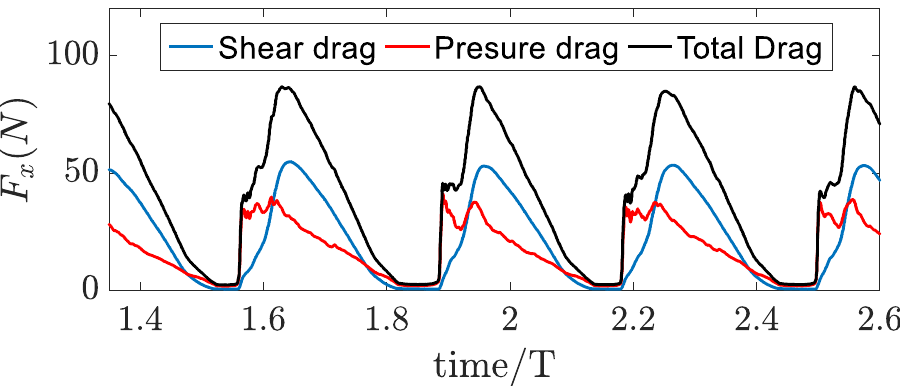
Figure 11. Time history of drag force, and its different components when the tunneled vessel Model B operate in waves with a beam Froude number of 4.7. The vertical motion of the body is caused by waves with a wavelength of